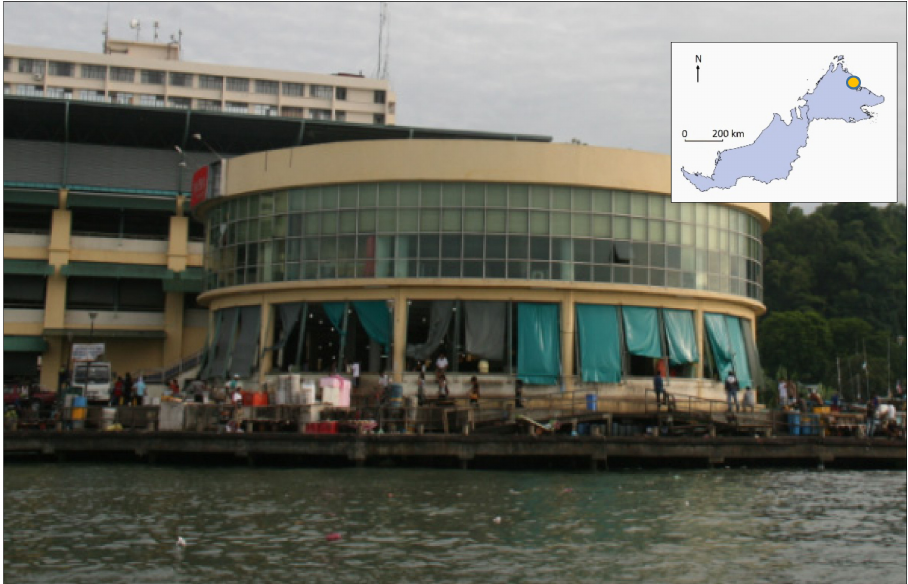
Figure 21. Proposed raised seawall and coastal bunds Sandakan town [139]. Reprinted from. Sea Level Rise Impacts and Adaption Measures for Sandakan, 2014; open access publication by HENRY Repository.